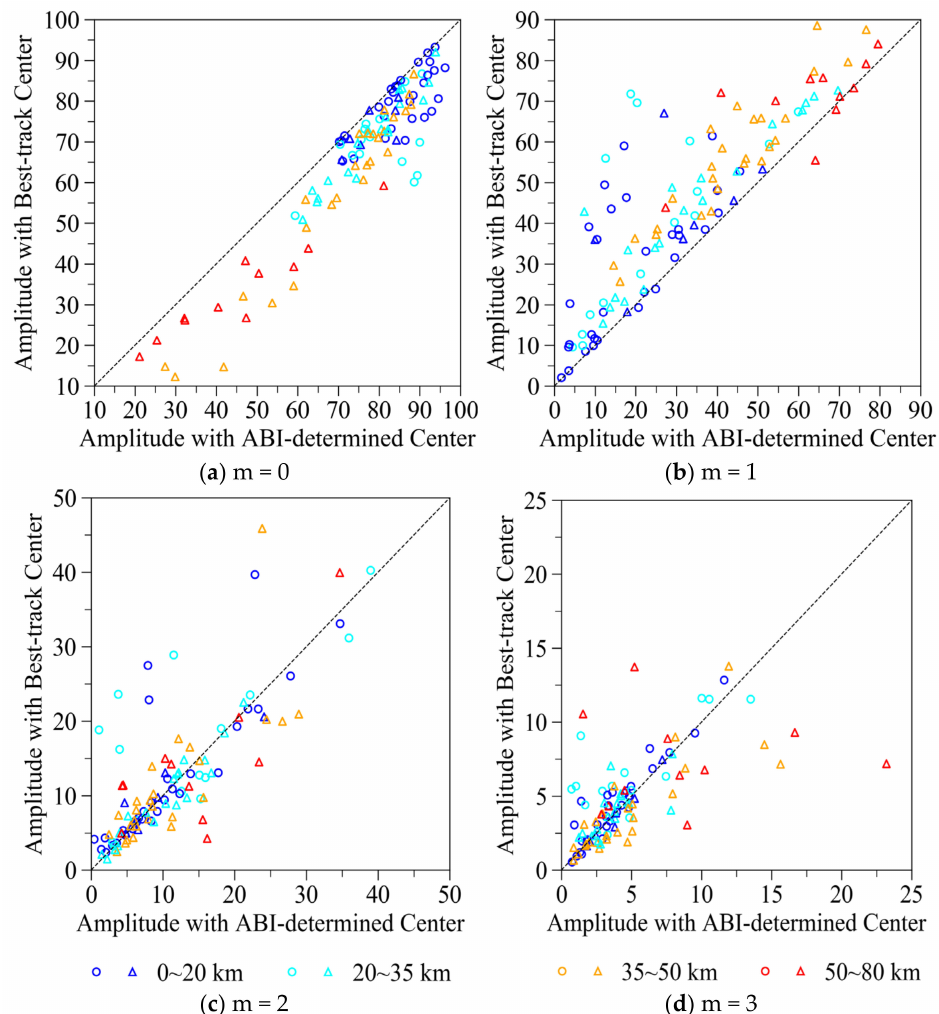
Figure 15. Scatter plots of ( a ) average amplitude (%) of wavenumber 0, ( b – d ) maximum amplitude (%) of wavenumbers 1, 2, and 3 from 20 km to the outermost radius of the azimuthal spectral analysis with the ABI-determined center and best track center as the center for the spectral decomposition for 45 times of Hurricane Irma (open circle) and 63 times of Hurricane Jose (open triangle). The differences (km) between the ABI-determined centers and best-track centers are indicated by